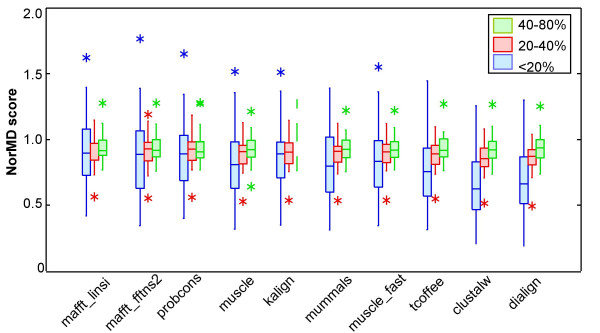
Program NorMD scores at different levels of overall sequence similarity. Box plots of the NorMD scores, representing the alignment quality of the full length alignment, obtained by the different alignment programs for the different similarity categories in subset 1. The boxplots indicate the extreme observations (stars), lower quartile, median, upper quartile, and largest observation. Programs are displayed in the order of the Friedman test using the NorMD scores for group V11 (additional file 1), with the highest scoring program on the left.